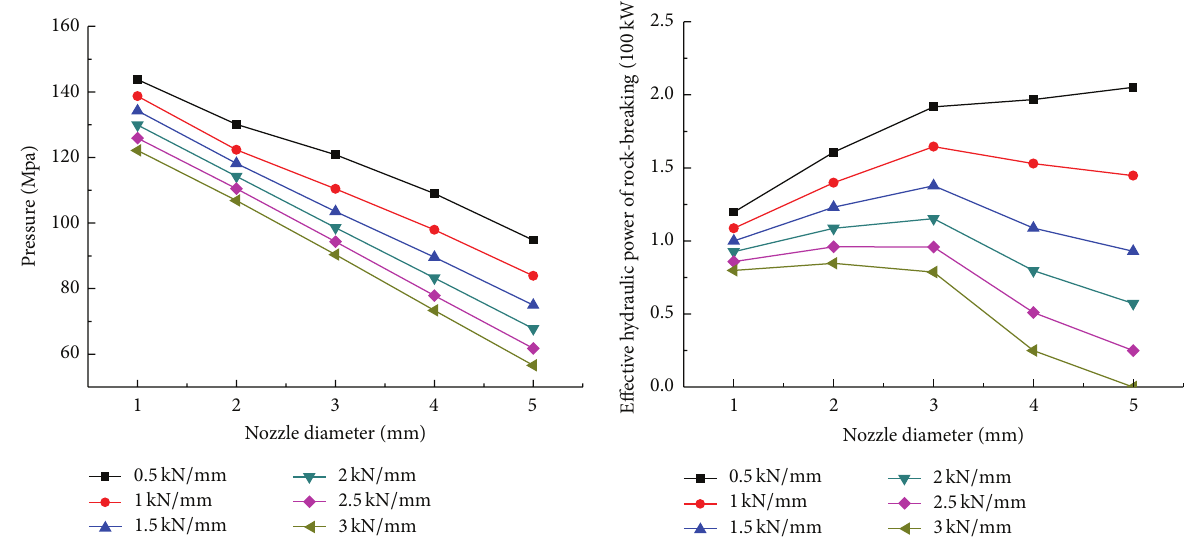
Figure 5: Effect law of hyperpressure nozzle diameter on device working behavior.